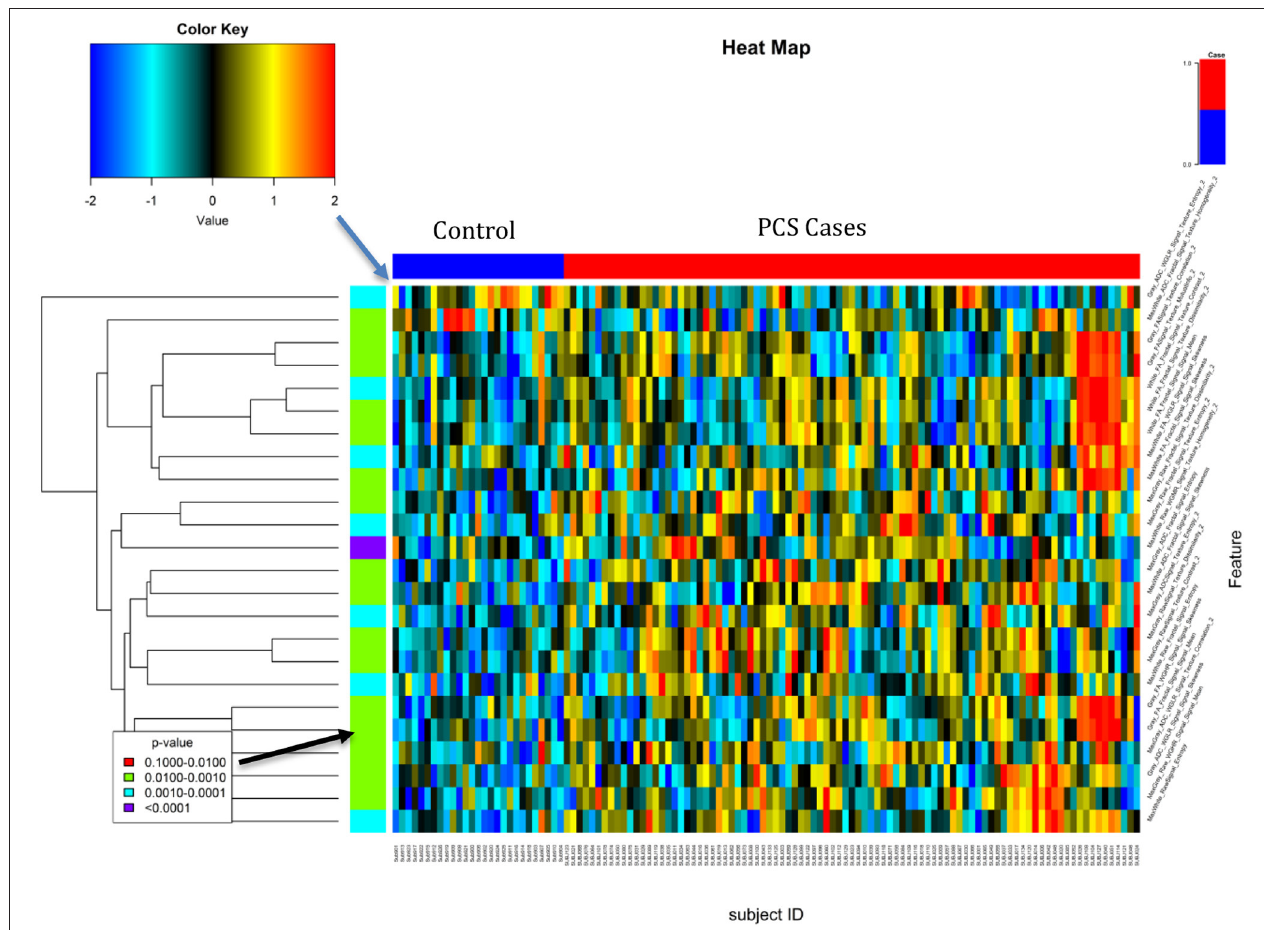
FIGURE 5 | Heat map of the top features associated with PCS. The top feature was the White Matter Homogeneity maximum deviation of the lobes Max from the second level Wavelet decomposition and the